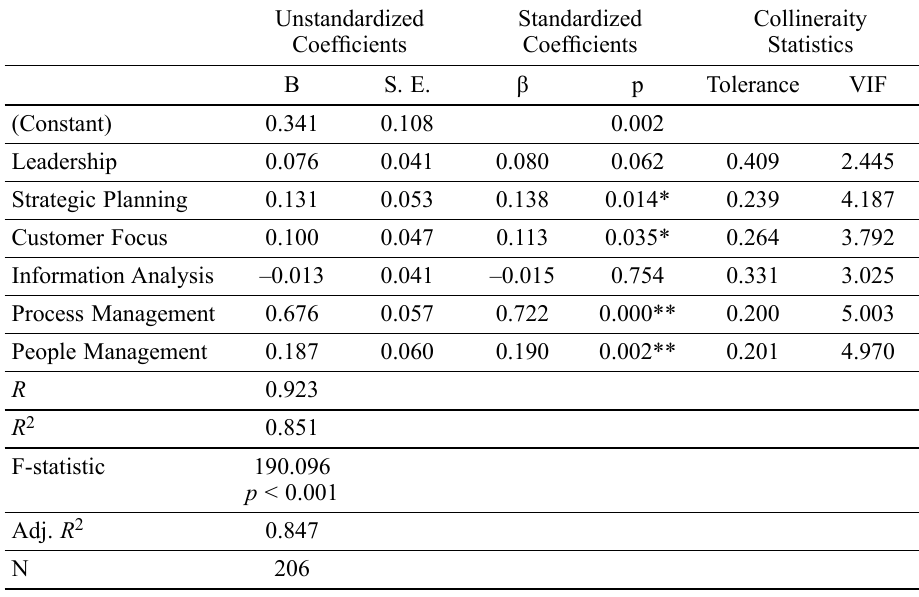
Table 5. Regression analysis of TQM practices on innovation